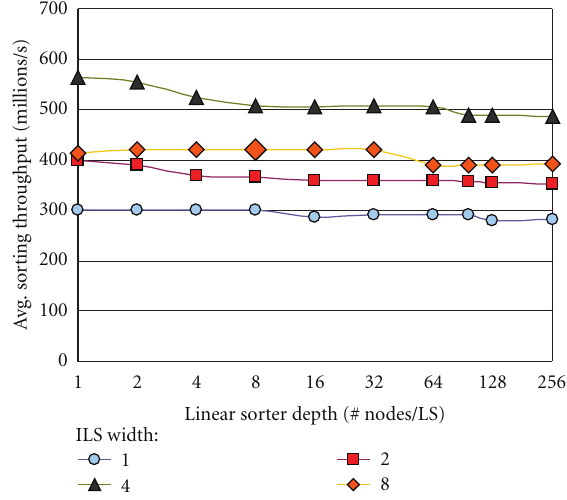
Figure 11: Normalized throughput for interleaved linear sorter